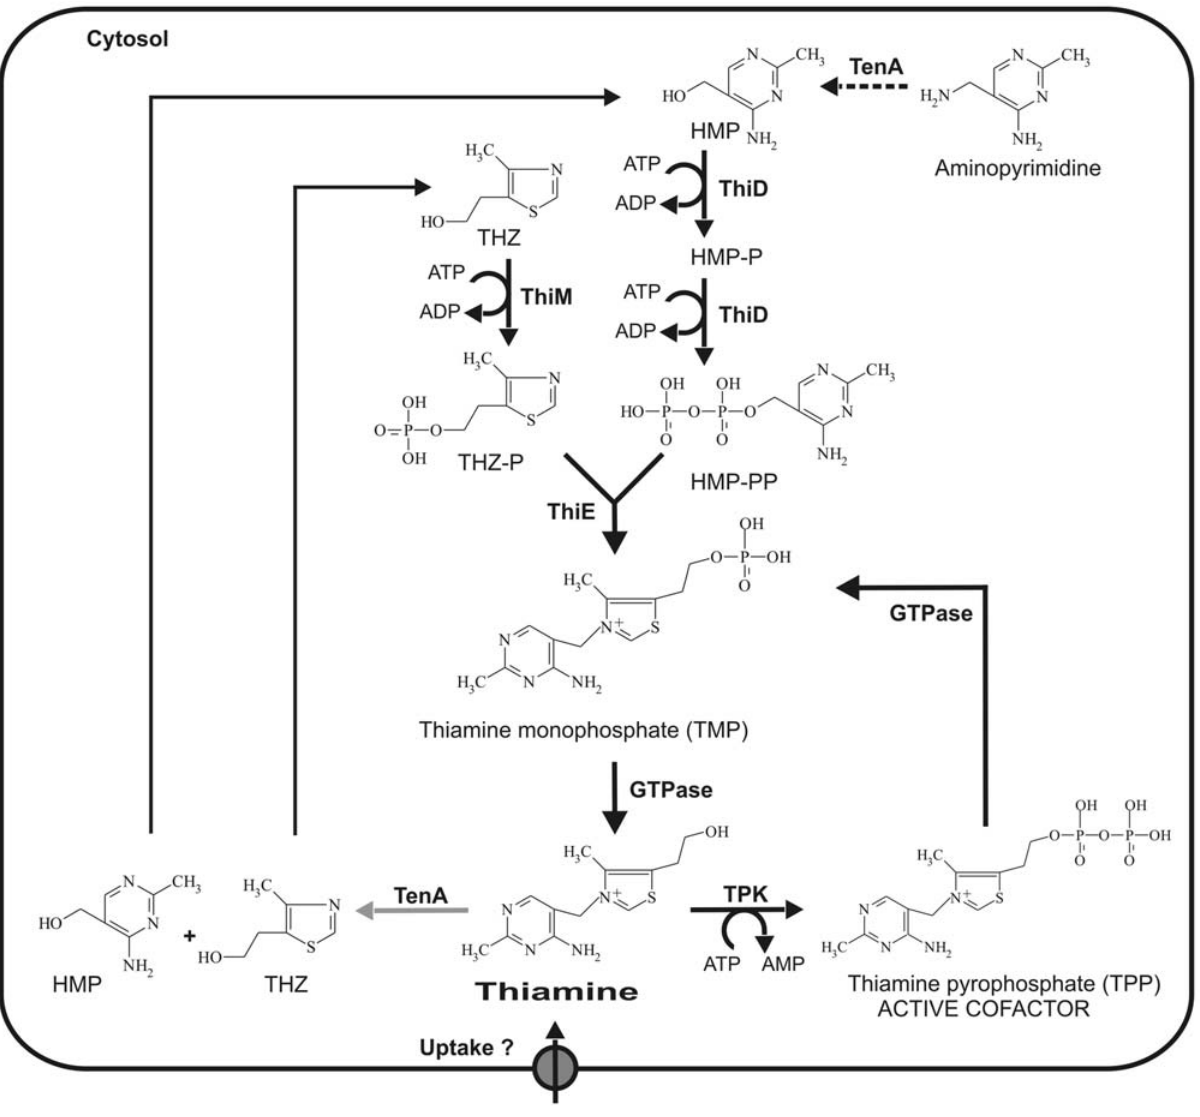
Figure 7. Schematic illustration of the proposed vitamin B1 metabolism in S.aureus . TenA is suggestedto be involved in pyrimidine salvage leading to HMP as indicated by a dotted arrow [34]. However, TenA is also capable to degrade thiamine into HMP and THZ in S. aureus (grey arrow).